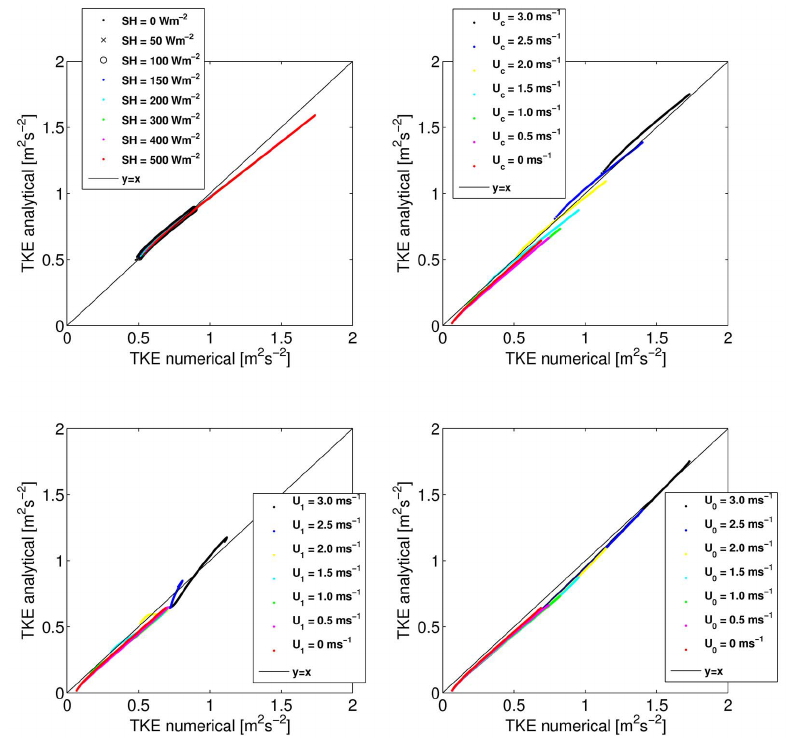
Figure 13. The figure shows a comparison between the numerically modeled TKE and the simplified analytical quasi-stationary expression of Eq. (20). The numerical model simulations correspond to those shown in Fig. 12, with SH runs shown in the upper left, U c runs in the upper right, U inc in the lower left and U dec runs in the lower right. Each simulation is identified in the legend of each panel by its set variable